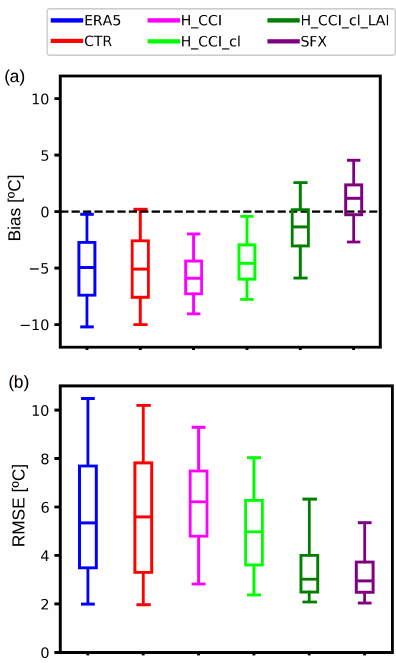
Figure 6. Boxplots of JJA daily maximum (a) LST bias and (b) RMSE computed over the 2004–2015 period for from ERA5 (blue), CTR (red), H_CCI (pink), H_CCI_cl (light green), H_CCI_cl_LAI (dark green), and SFX (purple). The boxplot spread represents different grid points over Iberia. Only time instants un- der clear-sky conditions are considered. The boxes represent the 25th-to-75th percentiles, while the whiskers represent the 5th and 95th